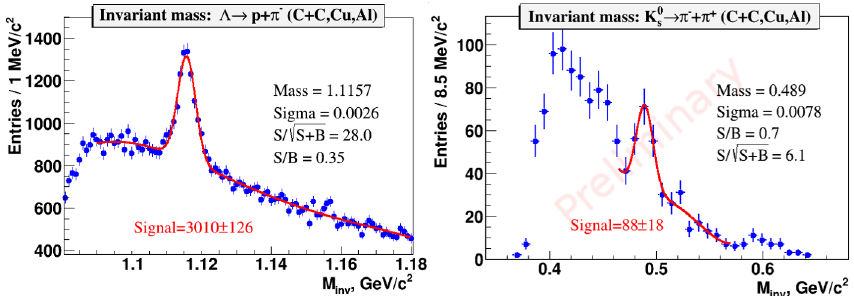
Figure 10. Left) Invariant mass spectrum of proton + π − pairs, Right) Invariant mass spectrum of π + + π − pairs